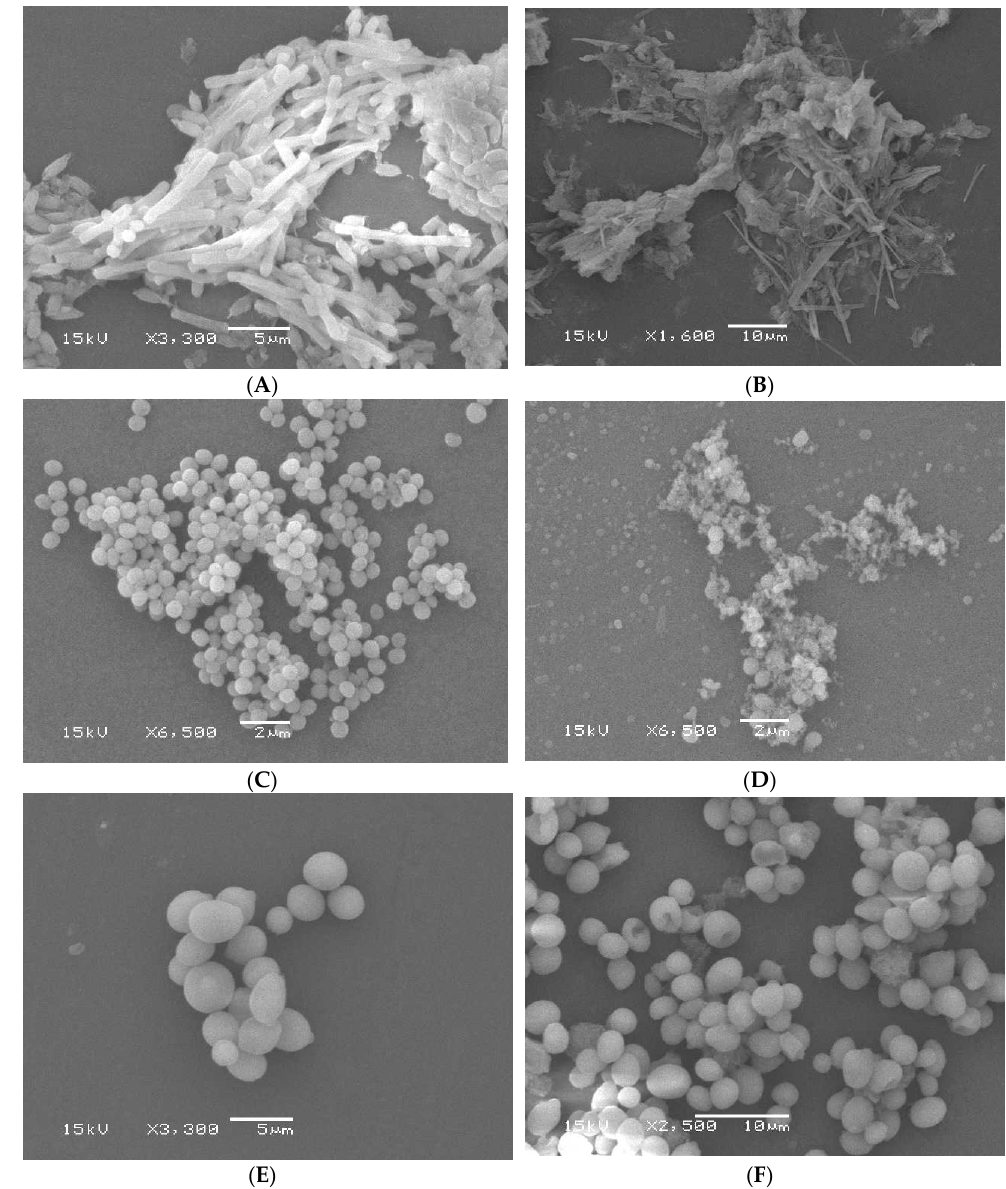
Figure 2. ( A ) Scanning electron microscopy (SEM) image of normal Bacillus subtilis ( B. subtilis ) cells; ( B ) SEM of compound 5b after 24 h incubation with B. subtilis ; ( C ) SEM of normal Staphylococcus aureus (S. aureus) cells; ( D ) SEM of compound 5b after 24 h incubation with S. aureus ; ( E ) normal mount of Candida albicans (C. albicans) cells; ( F ) SEM of compound 5j after 24 h incubation with C. albicans .